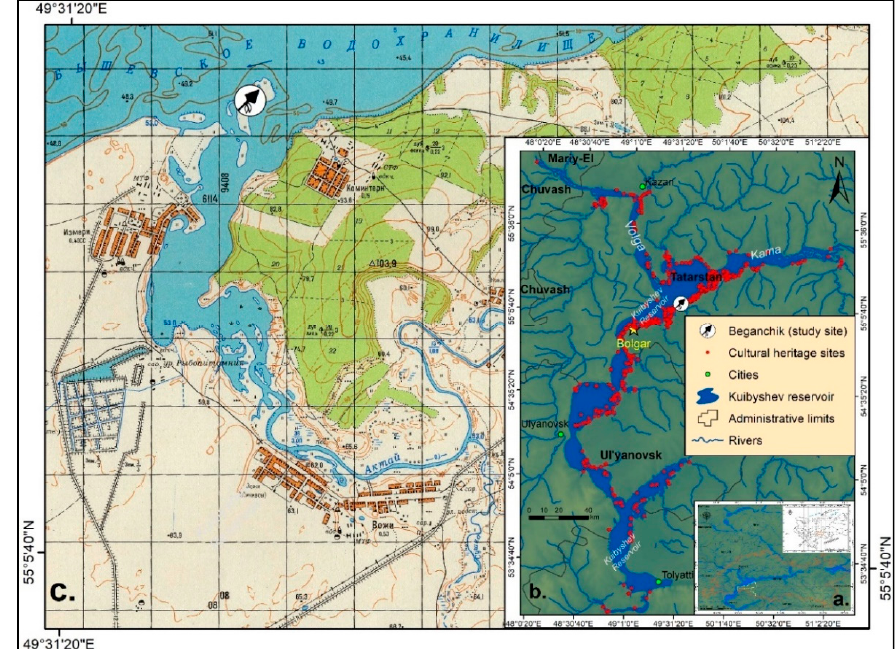
Figure 2. Geographical location of: ( a ) Kuibyshev reservoir in a regional context; ( b ) Kuibyshev reservoir and the cultural heritage sites around it; ( c ) Beganchik site on the topographic maps scale 1:50.000 (edition 1984). Water 2019 , 11 , x FOR PEER REVIEW